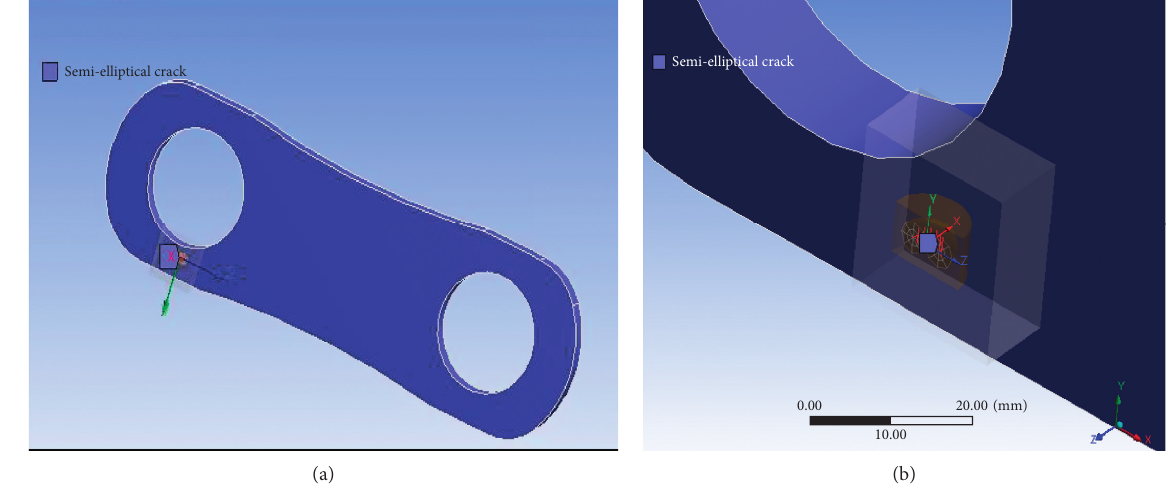
Figure 5: Modeled semielliptical crack: (a) semielliptical crack and (b) expanded view of semielliptical crack.